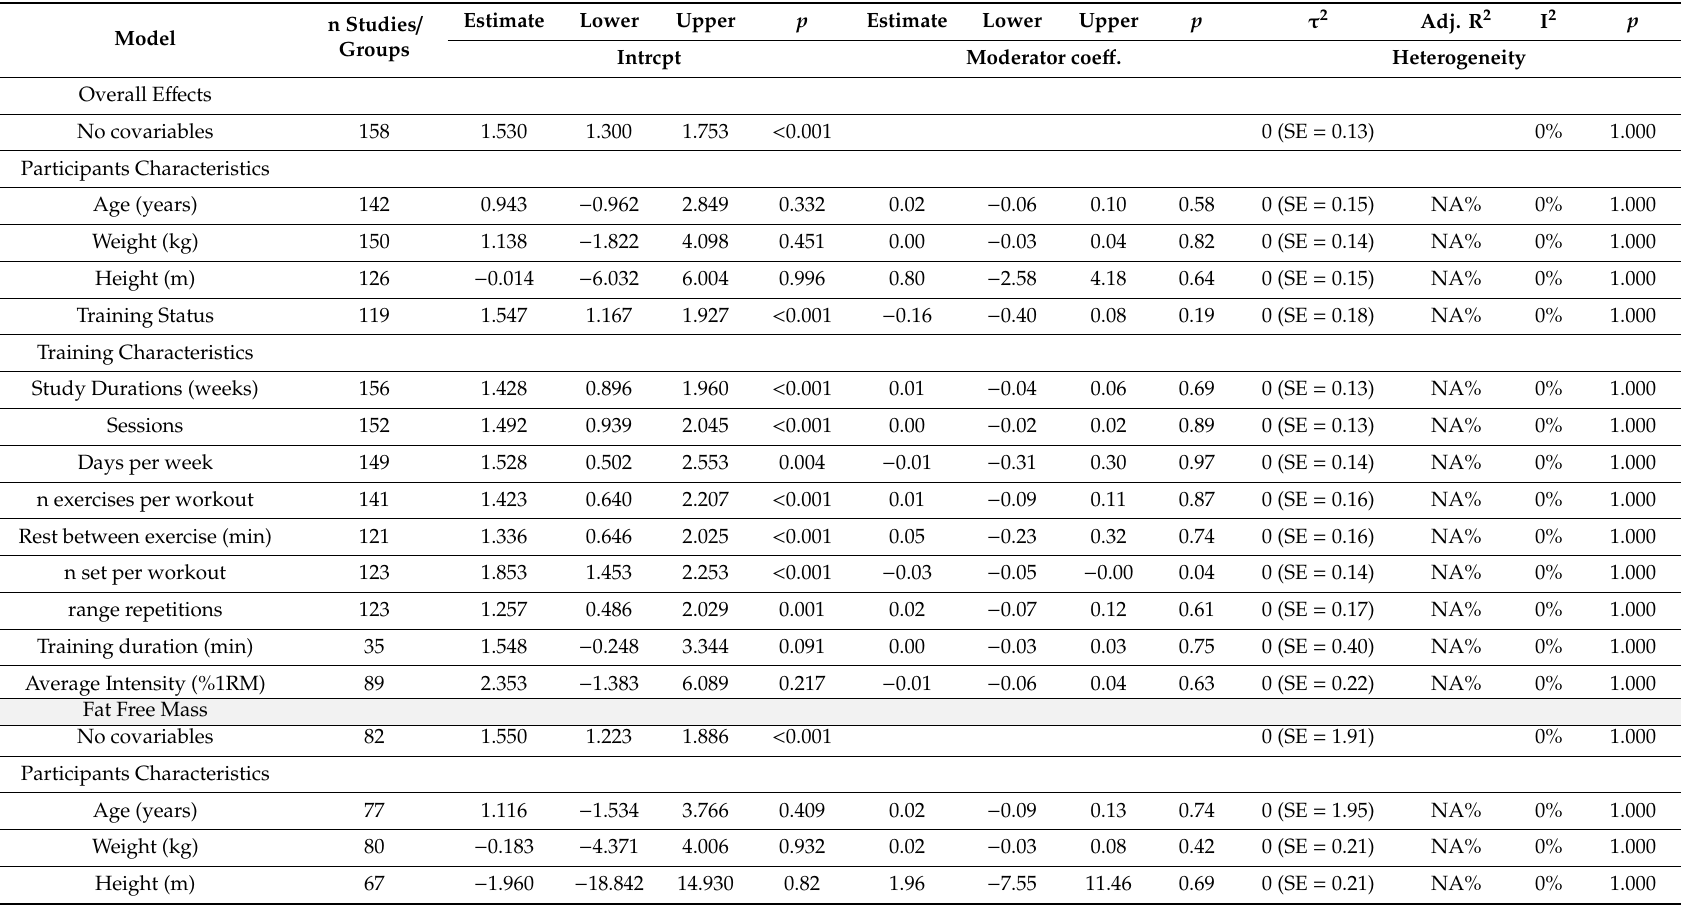
Table 2. Metaregression analisys taking in to account de participants and training characteristics, at the begin the